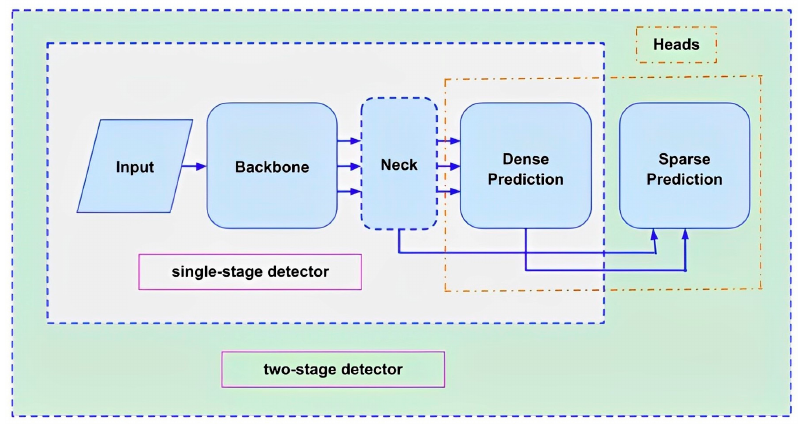
Figure 17. Conformation of object detector